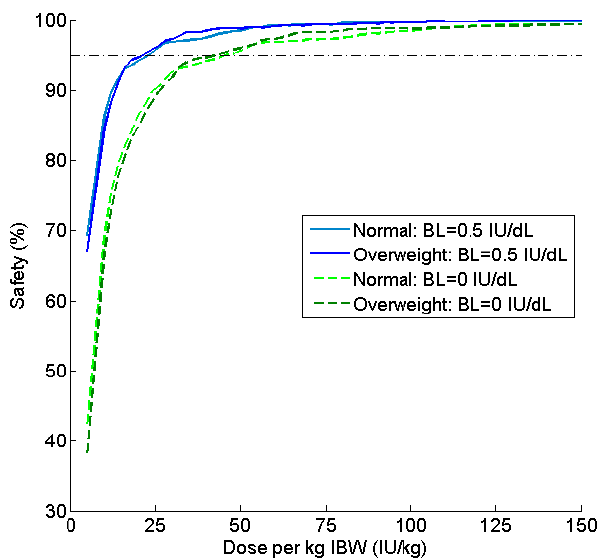
Figure 4. Comparison of safety profiles for patients simulated with baseline 0.5 IU dL − 1 and 0 IU dL − 1 for a Q48 h regimen. Safety (%) is the percentage of patients with C min ≥ 1 IU dL − 1 at various doses per kg of IBW.